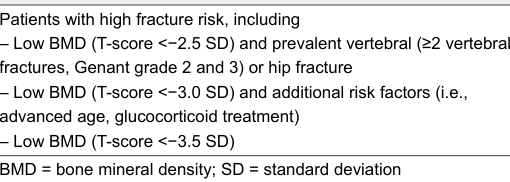
Table 2: Potential candidates for first-line treatment with teriparatide. Patients with high fracture risk, including – Low BMD (T-score <−2.5 SD) and prevalent vertebral (≥2 vertebral fractures, Genant grade 2 and 3) or hip fracture – Low BMD (T-score <−3.0 SD) and additional risk factors (i.e., advanced age, glucocorticoid treatment) – Low BMD (T-score <−3.5 SD) BMD = bone mineral density; SD = standard